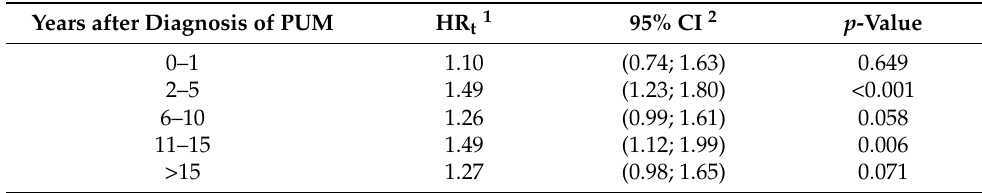
Table 4. Time-dependent hazard ratios of new primary cancer following the diagnosis of posterior uveal